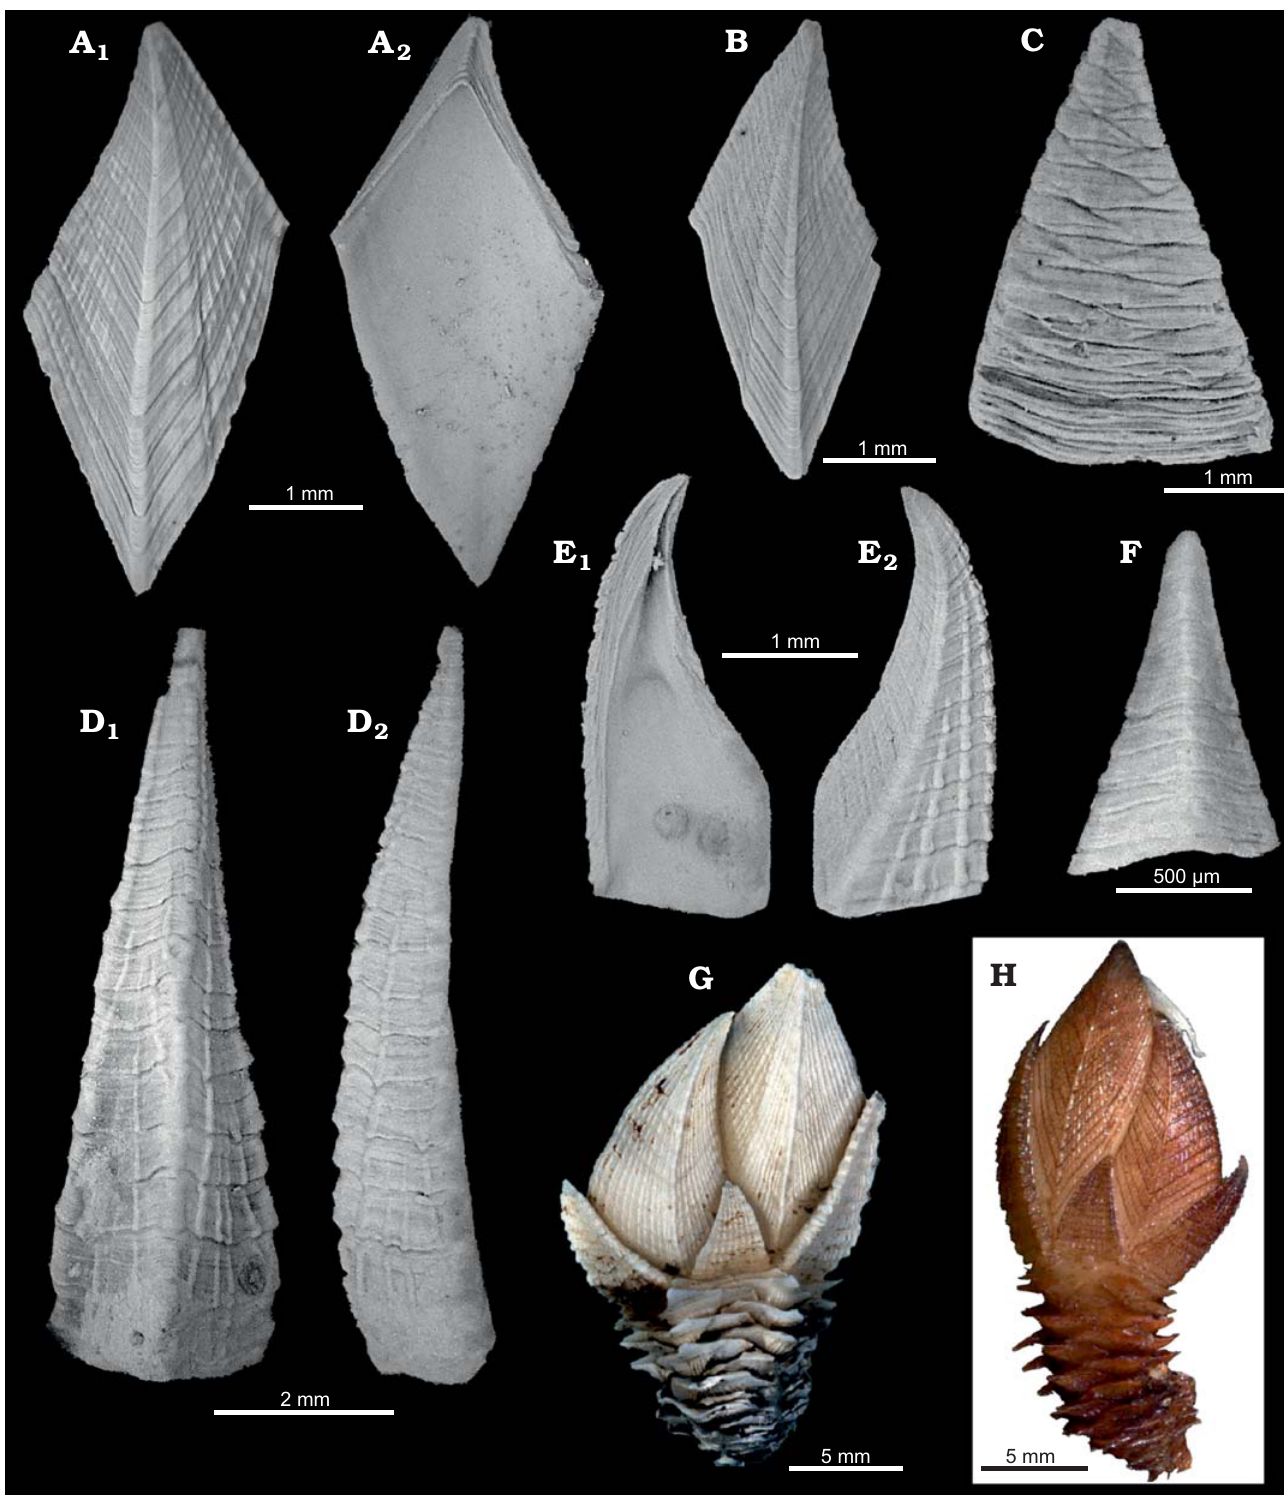
Fig. 3. Capitular plates of neolepadid cirripede Ashinkailepas indica Gale sp. nov. from Late Pleistocene (52.6 ka), Krishna-Godavari Basin, offshore India (A–G) and living species of the genus (H, I). A – F . Capitular plates of paratypes. A . NHMUK IC 1402, tergum in external (A 1 ) and internal (A 2 ) views. B . NHMUK IC 1403 small tergum in external view. C . NHMUK IC 1404, upper latus in external view. D . NHMUK IC 1405, carina in dorsal (D 1 ) and lateral (D 2 ) views. E . NHMUK IC 1406, small scutum in internal (E 1 ) and external (E 2 ) views. F . NHMUK IC1407, rostrum in ventral view. G .